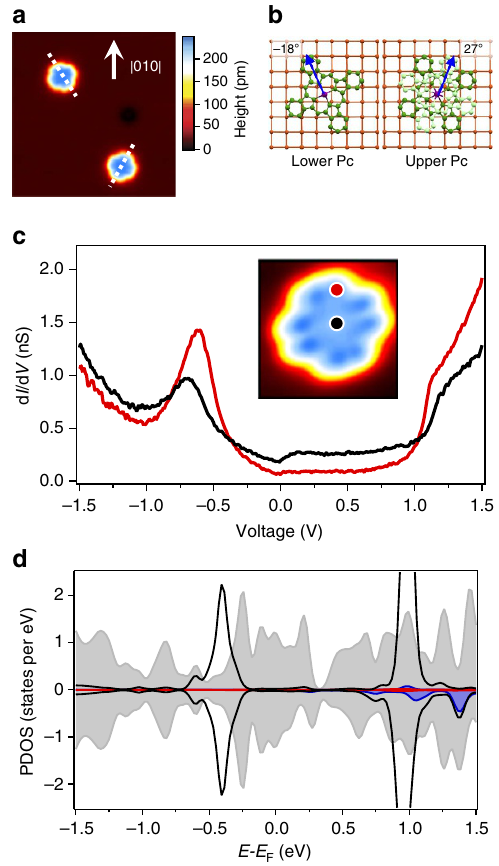
Figure 1 | DyPc 2 on Cu(001). ( a ) STM topographic image (18.6 (cid:2) 18.6nm; V set ¼ (cid:3) 0.1V, I set ¼ 0.1nA) of DyPc 2 molecules, which are observed to bind at two angles, as marked with a dotted white line. ( b ) Schematic of the binding of molecules to the surface, showing the lower (dark green) and upper (light green) Pc ligands, with the centre of the molecule placed over the hollow site in the Cu(001) surface 25 ; the central Dy atom is shown. Pc molecules have been observed to bind at ± 18 (cid:2) . For an assumed rotation of 45 (cid:2) , the top Pc ring will appear at 8 27 (cid:2) , which is approximately the observed angle of the molecules. ( c ) High-voltage spectroscopy ( V set ¼ (cid:3) 1.5V, I set ¼ 0.1nA) acquired over the ligand (black) and the centre (red) of a DyPc 2 molecule (positions shown in inset on an STM topographic image, 3.5 (cid:2) 3.5nm, V set ¼ (cid:3) 0.2V, I set ¼ 0.1nA). ( d ) Calculated partial density of states (PDOS) of p states in the top (black) and bottom ligand (grey), and Dy d - (red) and f -states (dark blue). The lower ligand is strongly hybridized with the surface and also weakly hybridized to the top